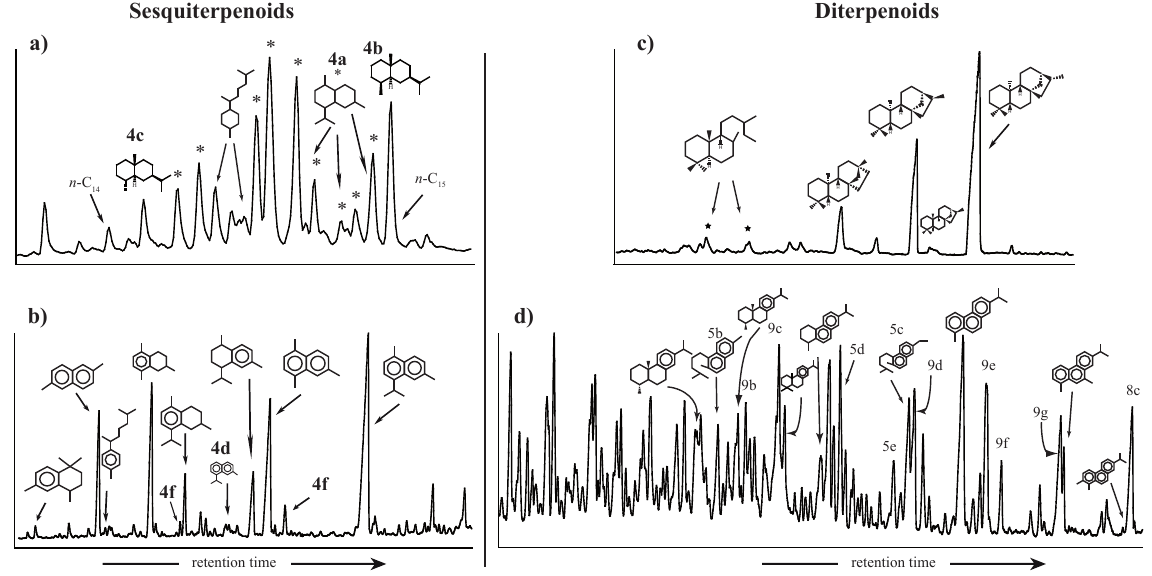
Fig. 12. Partial chromatograms (sesquiterpenoids (a, b) and diterpenoids (c, d) retention time windows) of aliphatic (a, c) and aromatic (b, d) fractions of pyrolysates of Wollemia nobilis . The mass spectra of 4a, 4b, 4c, 4d and 4f are given in Fig. 4. The mass spectra of 5b to 5e are given in Fig. 5. The mass spectra of 8c are given in Fig. 8. The mass spectra of 9b to 9f are given in Fig. 9. ∗ : cadalane-type